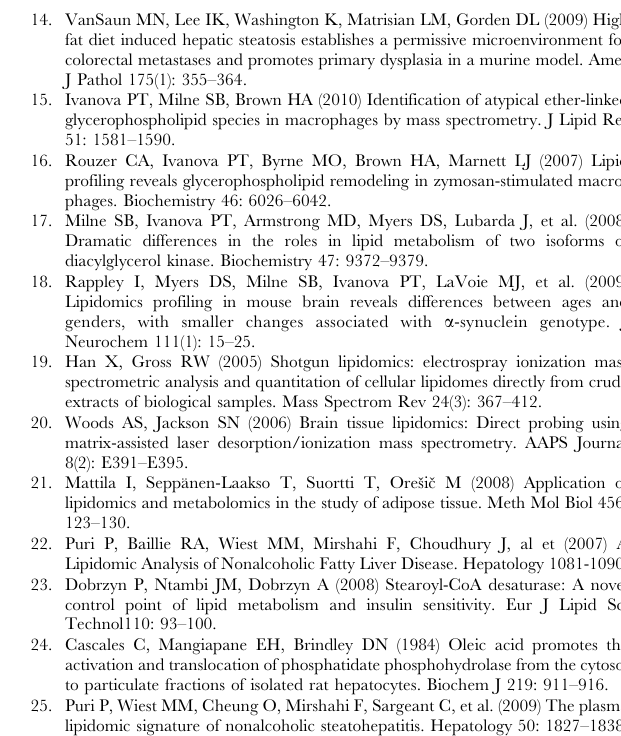
Figure S1 Fragmentation spectra of m/z 871 peak. MS/MS spectra of 38:4e PI from cirrhotic liver sample (eluting at 6.06 min). (TIF) Figure S2 MS/MS spectra of 18:0e/20:4 PI synthetic standard. Fragmentation pattern of the liver sample PI yielded fragments consistent with those appearing in the synthetic standard. (TIF) Table S1 Total number of identified phospholipid species in each of the human liver (normal, steatotic, and cirrhotic) and murine groups. The number includes the identification of isobaric species (having the same total carbon number and number of double bonds but presented in different fatty acids